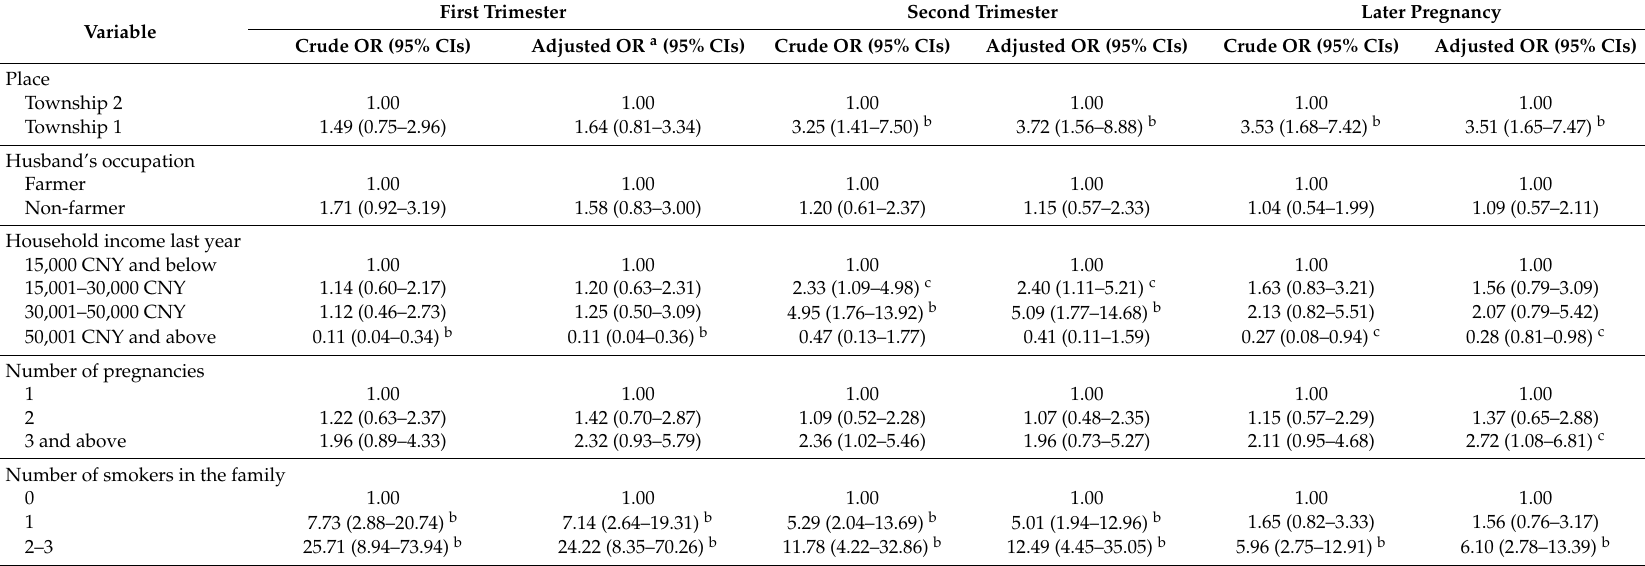
Table 3. Factors associated with the discrepancy between SR and UC-verified ETS exposure among rural pregnant